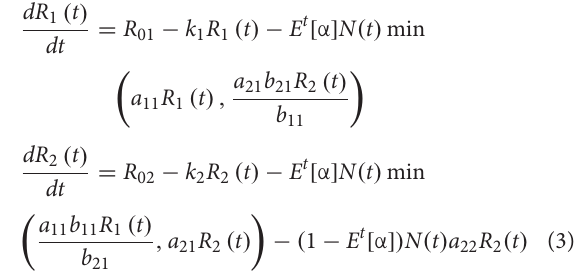
Region 2 of Figure 1 : A mix of ER + and ER − cells (0 < α < 1)